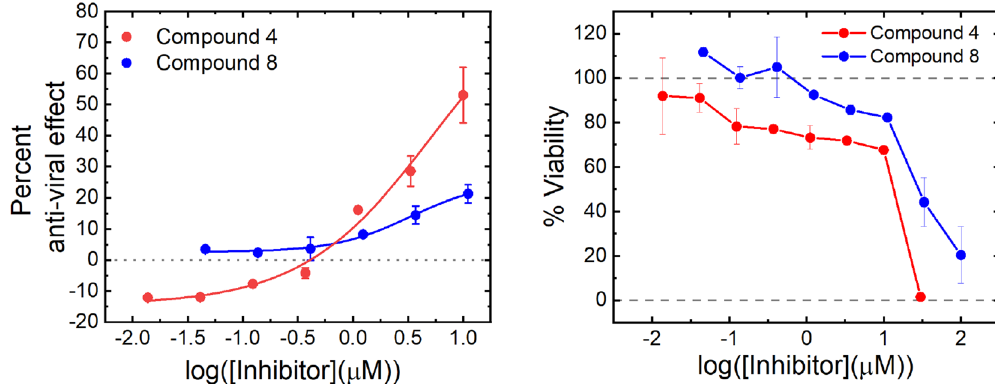
Figure 4. Anti-viral effect of compounds 4 and 8 . The left hand chart shows anti-viral effect of compounds 4 and 8 in HUH7_mCherry cells. An anti-viral effect was established after a 4-day incubation with SARS CoV-2 virus at concentrations which did not cause significant cytotoxic effects. The anti-viral effect was established by an increase in fluorescent cells counted compared to an untreated control. The right-hand chart shows cell viability after 4-days treatment with compounds 4 and 8 in HUH7_mCherry cells. Viability was established by counting the number of fluorescent cells. Data are shown as the average of two technical repeats with error bars representing the range. Data are representative of two technical repeats.